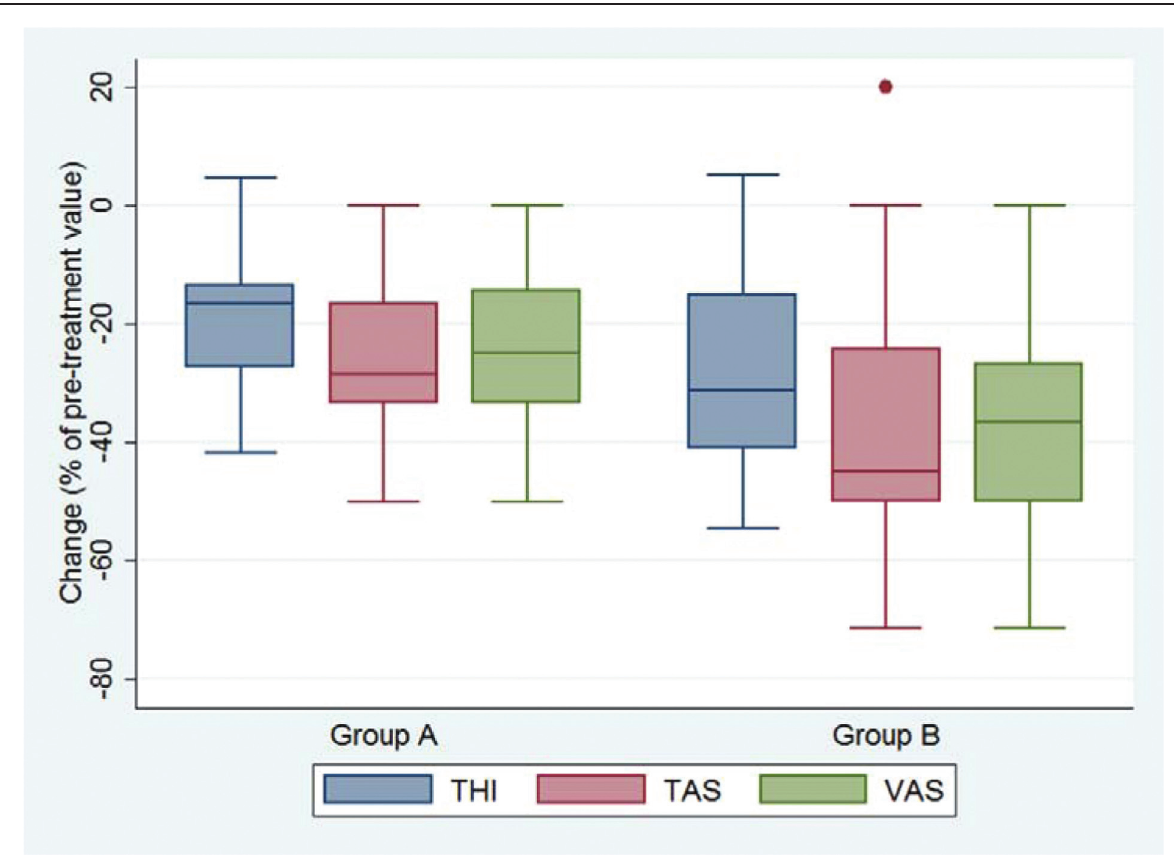
Box plot showing the percentage of change in subjective rating of symptoms in either study group. Box represents the range from the first quartile to third quartile (interquartile range). Line inside the box represents the median (second quartile).